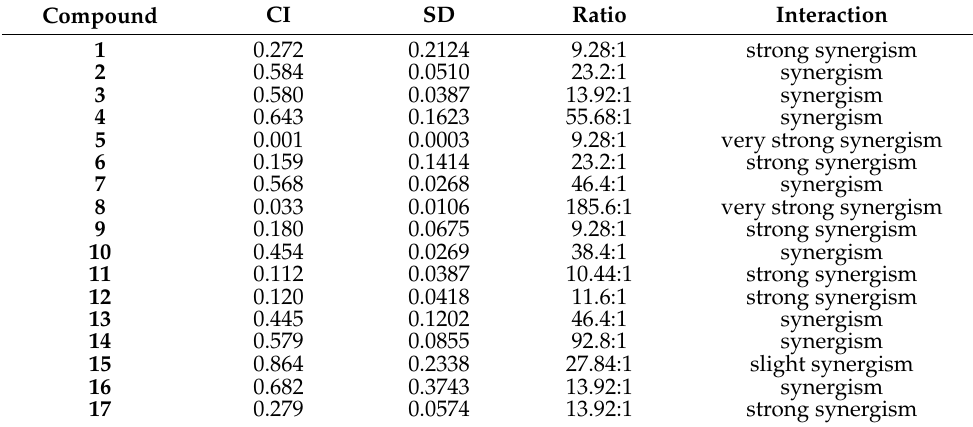
Table 7. Interaction type between doxorubicin and phenanthrenes ( 1 – 17 ) in HeLa